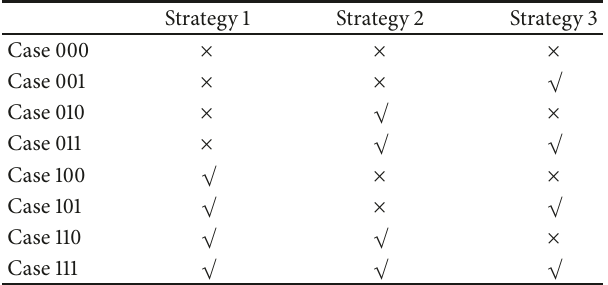
Table 1: Definitions and composition of eight